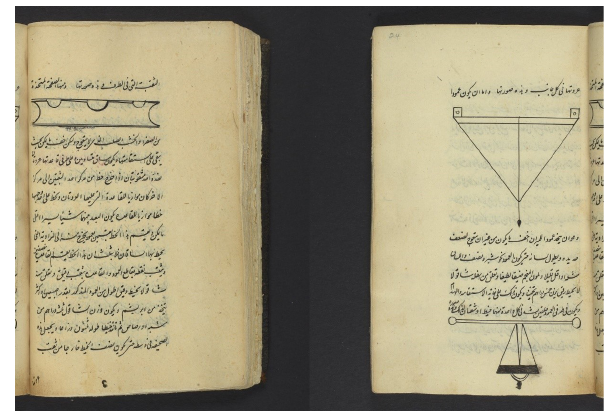
Figure 5. Illustrations of surveying apparatuses to measure distance and level and the proof and description on its application. Dia- grams f32r and f33r from Karaji (1675). Permanent link: http://hdl. library.upenn.edu/1017/d/medren/9948256513503681 (last access: 29 July 2019).